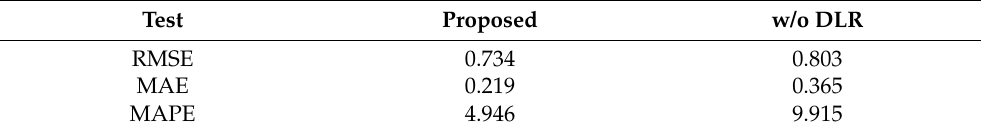
Table 3. Predicted results of ablation experiment comparison on the first working day in the